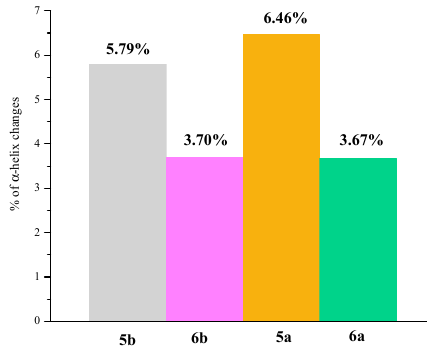
Figure 10. Changes in α -helix(%) of BSA after adding 10 portions of the compound—the comparison for 5a , 5b , 6a , and 6b .